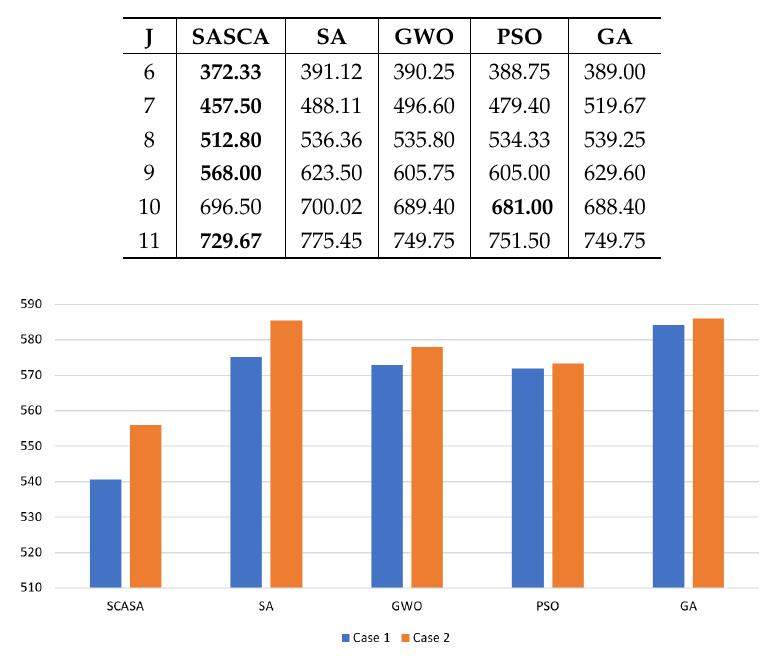
Table 14. Average of C max of the small problems on 2 machines for testing the sensitivity of the parameters (best results are in boldface).